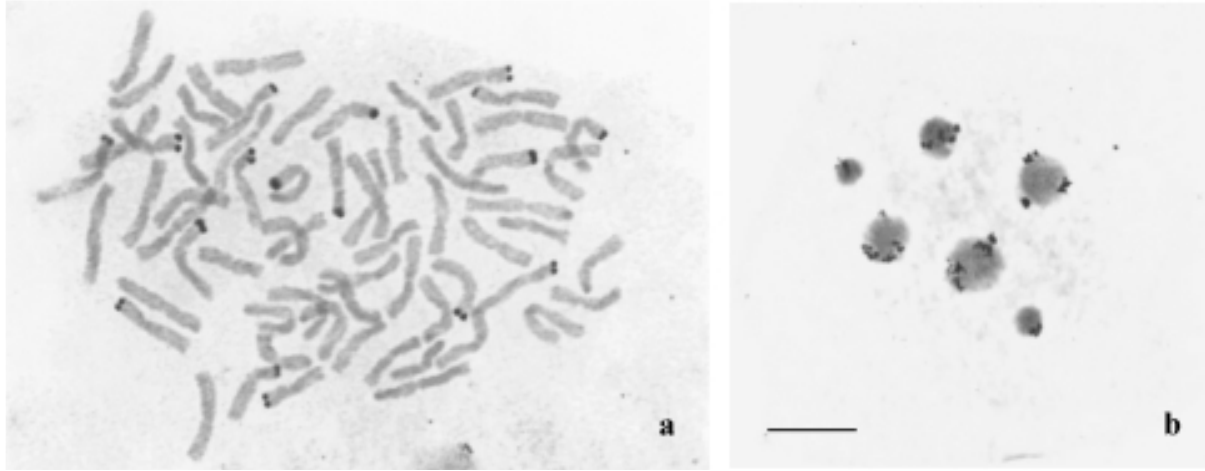
Figure 2 - Analysis of NOR activity, using the silver-staining procedure. a. Partial metaphase showing the maximum number of Ag-NORs found in a sin- gle cell (17 sites). b. Interphase nuclei with six nucleoli. Bar = 10 µ